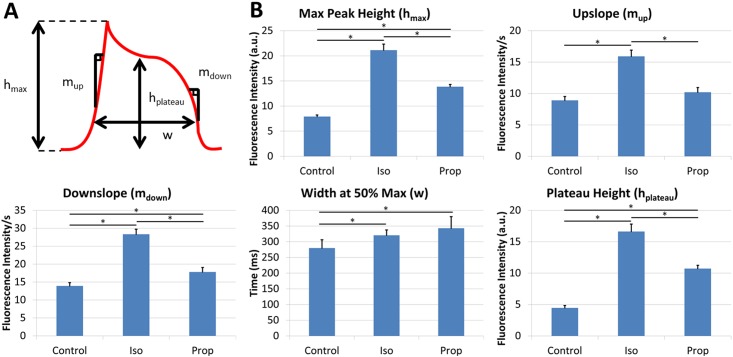
Average waveform metrics.Metric definitions: The maximum height (hmax) is defined as the maximum amplitude of the waveform. The upslope (mup) and downslope (mdown) are defined as the slopes at 50% of the maximum height. The peak width (w) is defined as the distance from upslope to downslope at 50% of the maximum height. The plateau height (hplateau) is defined as the height of the waveform at the midway point of the peak width (A). Average of waveform metrics (B). All error bars are SE. (*) indicates p<0.05 for a given comparison.